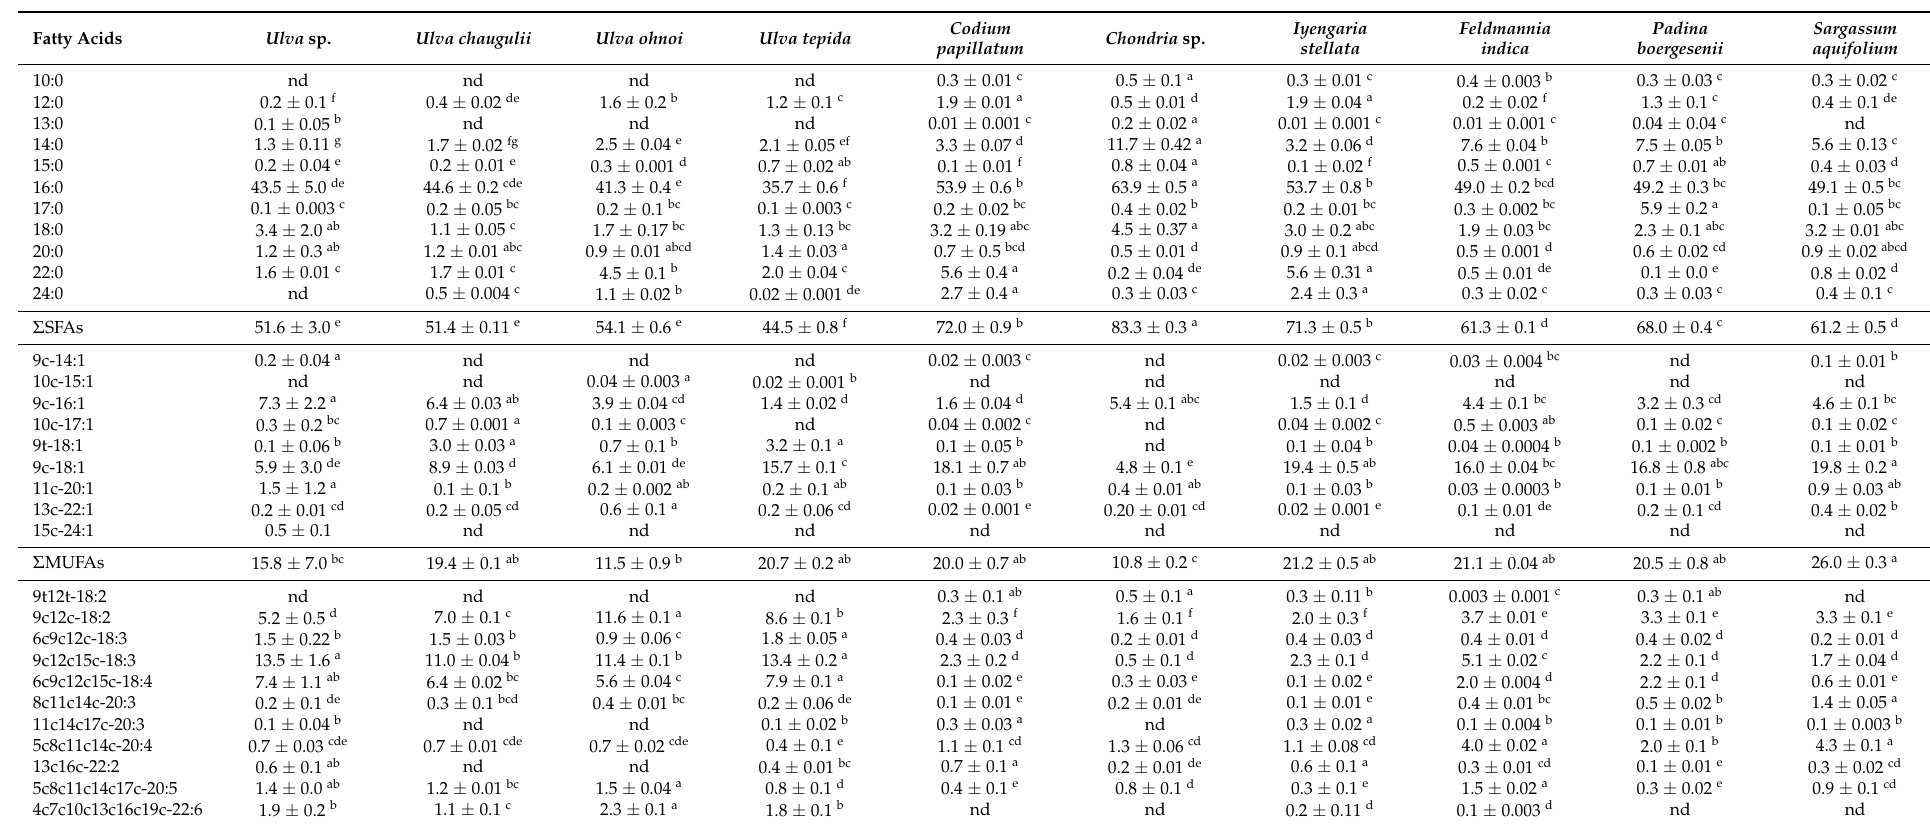
Table 2. Fatty acid composition (% of total fatty acid methyl esters) of different macroalgal species, expressed as means ± SD ( n =